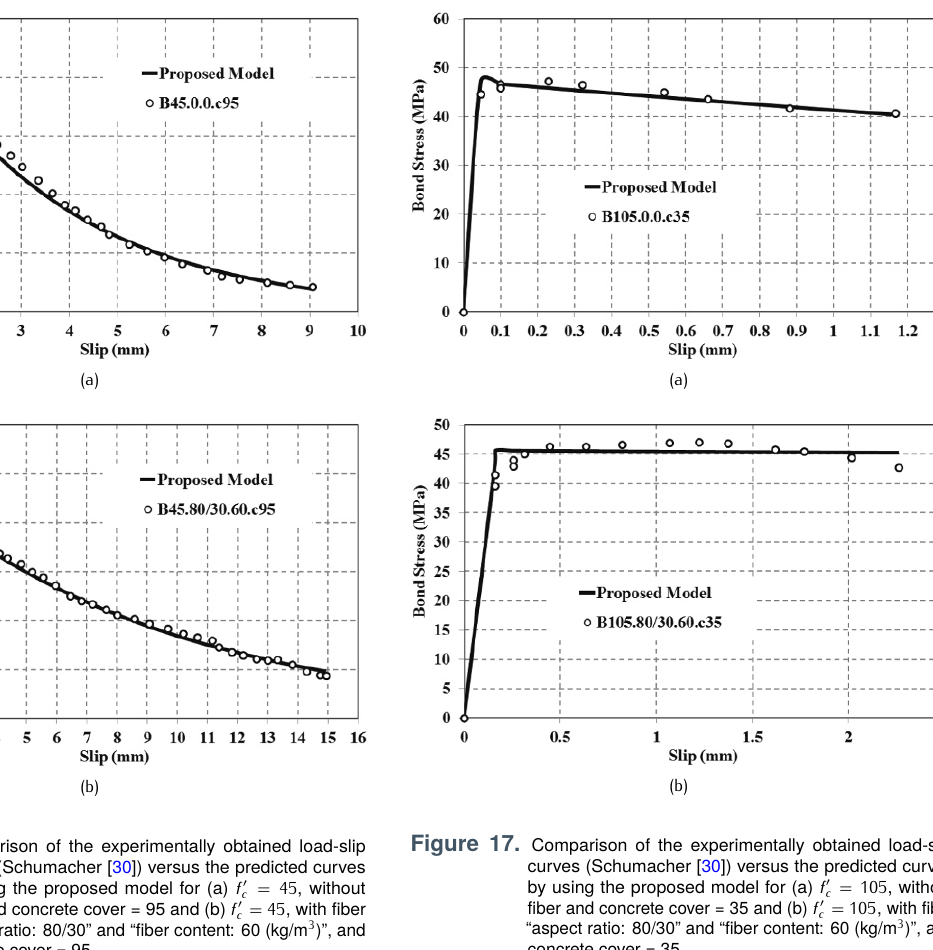
σ 0 ,peak : fiber peak pullout stress σ